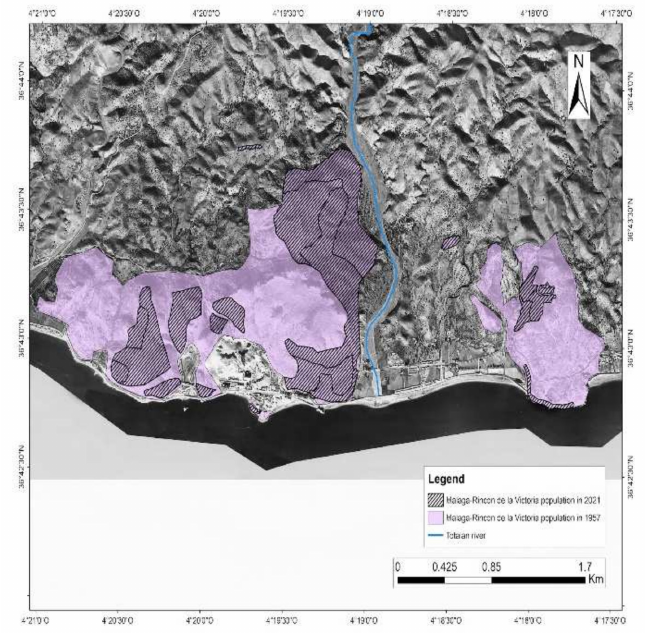
Figure 7. M á laga–Rinc ó n de la Victoria 5220* HCI: Current and 1956–57 potential AOO.